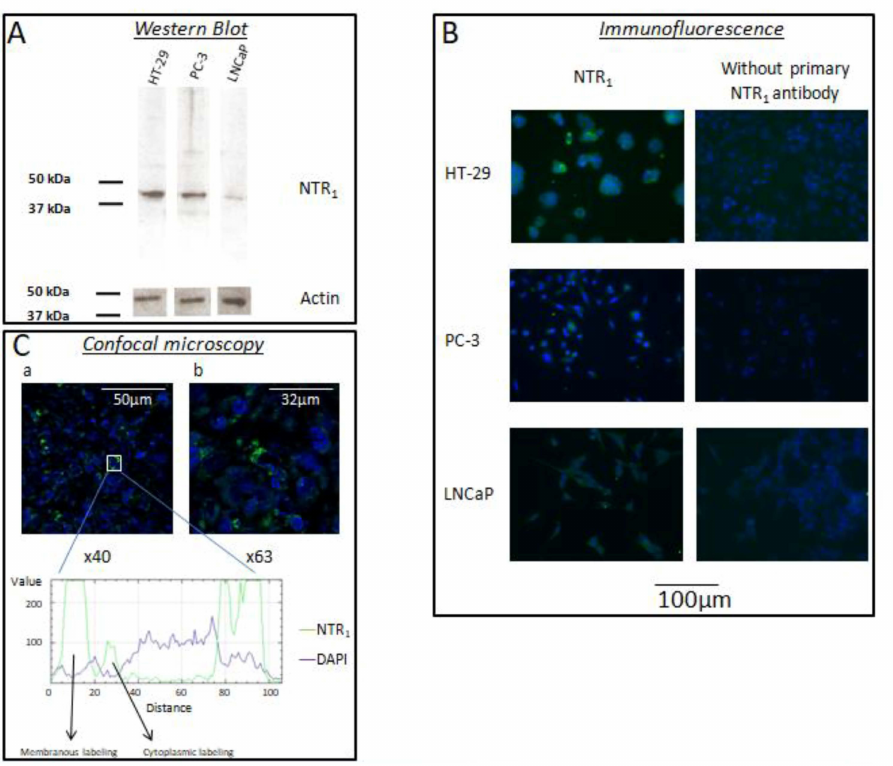
Figure 1. Expression profile of NTR 1 in prostate cancer cell lines PC-3 and LNCaP and the colonic cell line HT-29 (positive control). ( A ) Western blot of NTR 1 showing high expression in HT-29 and PC-3 cells and weak expression in LNCaP cells. ( B ) NTR 1 immunofluorescence revealing cytoplasmic and membranous labelling in HT-29 and PC-3 cells. ( C ) Confocal microscopy (40 × and 63 × magnifications) of a PC-3 xenograft confirming cytoplasmic and membranous